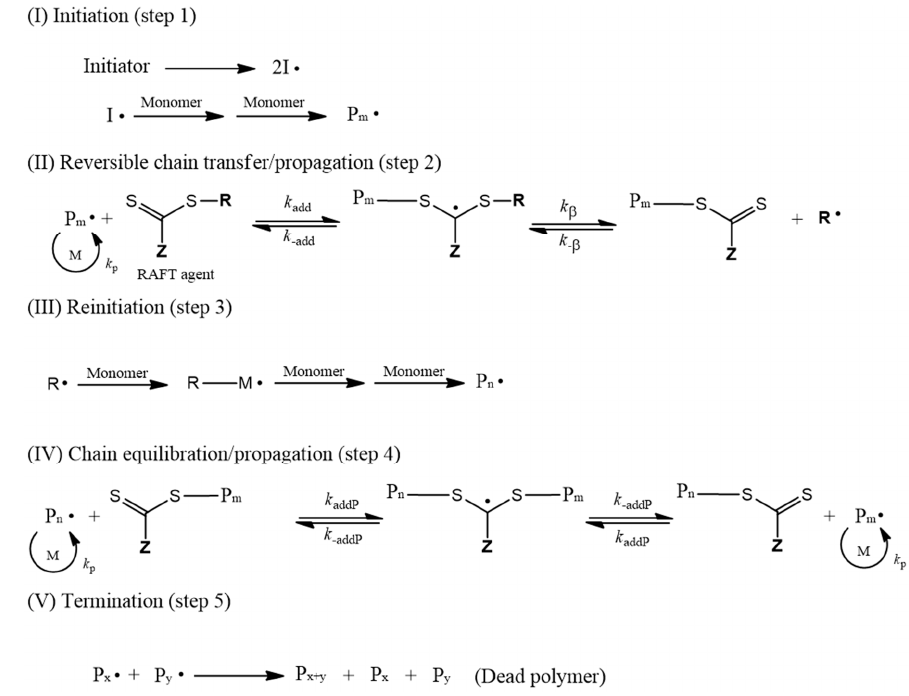
Figure 1. Scheme of reversible addition-fragmentation radical transfer (RAFT) polymerization.